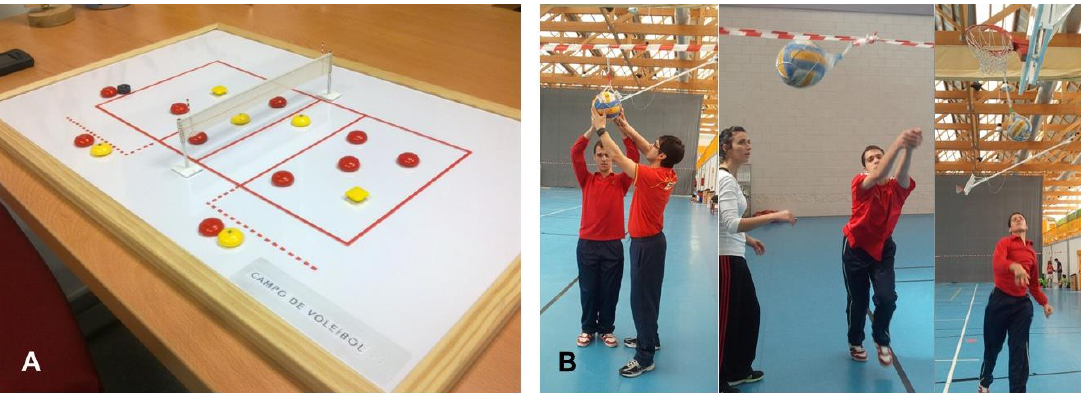
Figure 2. Adapted materials (A) and peer-tutoring technique learning (B) in